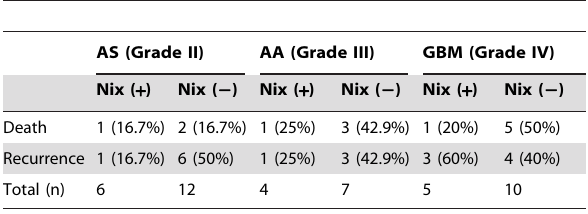
Table 1. Tumor-related death and recurrence in 44 patients with